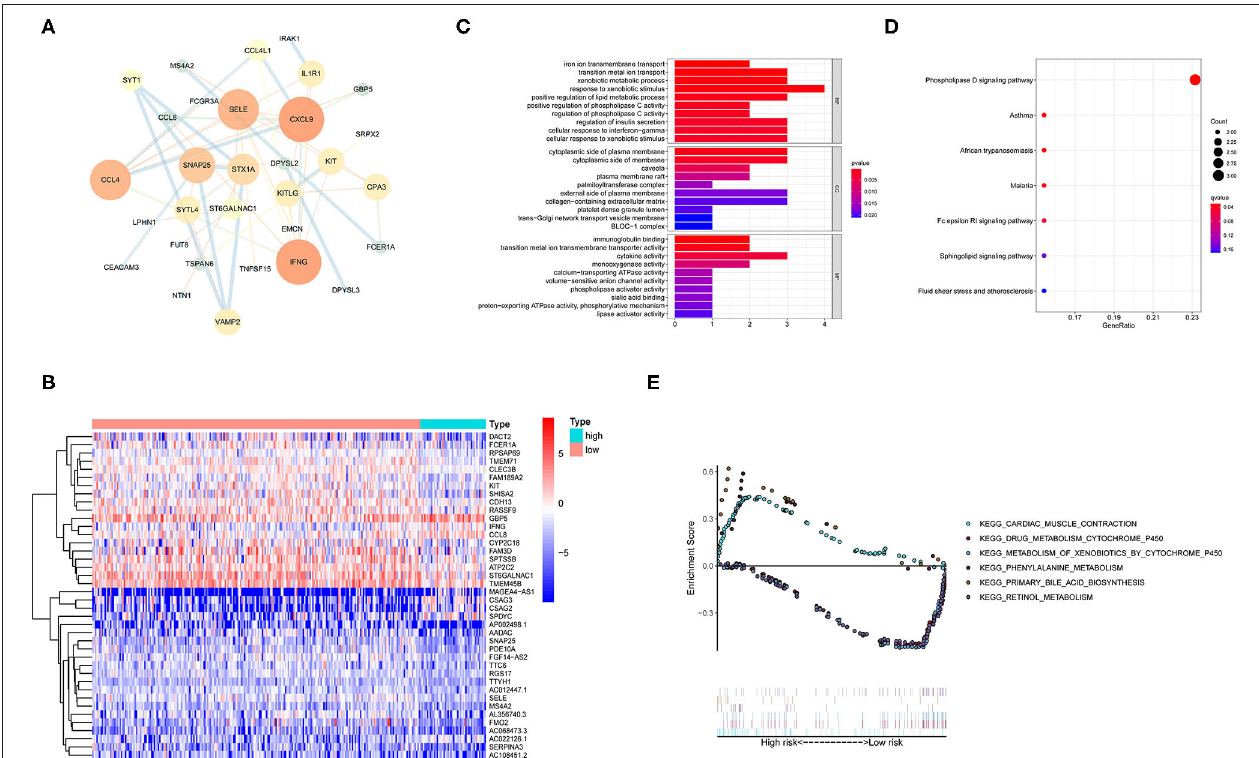
FIGURE 3 | Functional enrichment and enrichment pathway analysis of differentially expressed genes (DEGs). (A) Protein-protein interaction (PPI) network analysis of the DEGs. (B) Heatmap representing the top 40 DEGs. (C) Gene Ontology (GO) enrichment analysis revealing the functional enrichment terms of DEGs. (D) Kyoto Encyclopedia of Genes and Genomes (KEGG) pathway enrichment analysis showing the enriched pathways of DEGs. (E) Gene set enrichment analysis (GSEA) analysis representing the TMB-related KEGG pathways. Above the horizontal axis indicated the pathways are in the high TMB group, and below the horizontal axis indicated that the pathways are in the low TMB